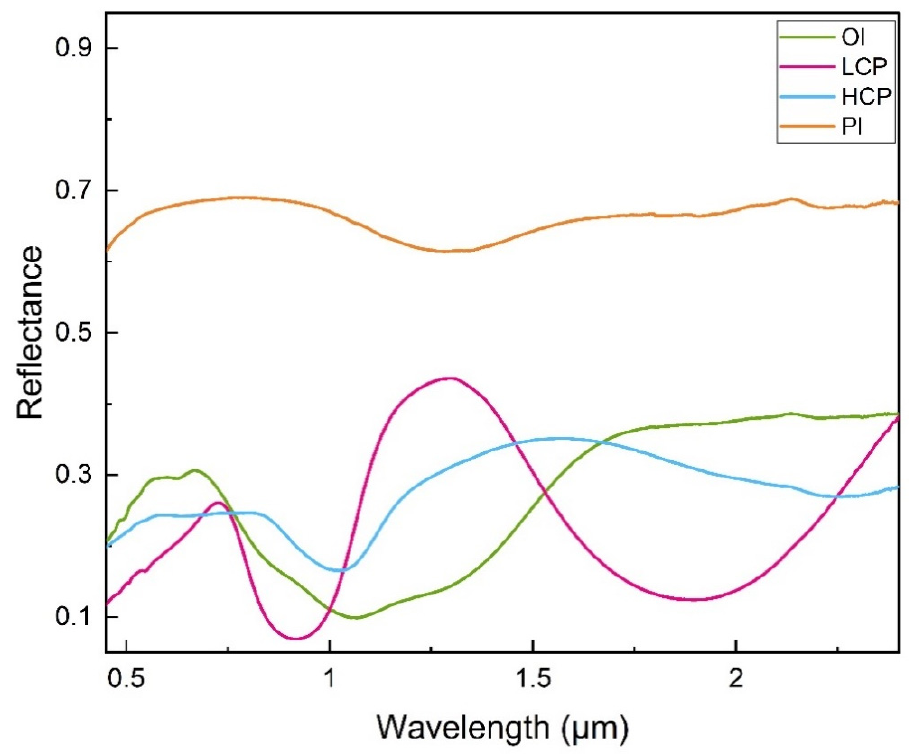
Figure 5. The spectra of end-members of CR-1 detected by TerraSpec-4. The green, pink, blue, and orange lines show the spectra of olivine, LCP, HCP, and plagioclase, respectively. The spectra of CR-1 detected by the VNIS SF exhibited evident absorption features at wavelengths of 971 (±1) nm and 1957 (±8) nm (Figure 6), which were longer at 1000 nm and shorter at 2000 nm than those of the Chang’e-4 rock. The results are similar to those of the Chang’e-4 rock but probably have more calcium and less iron [25].